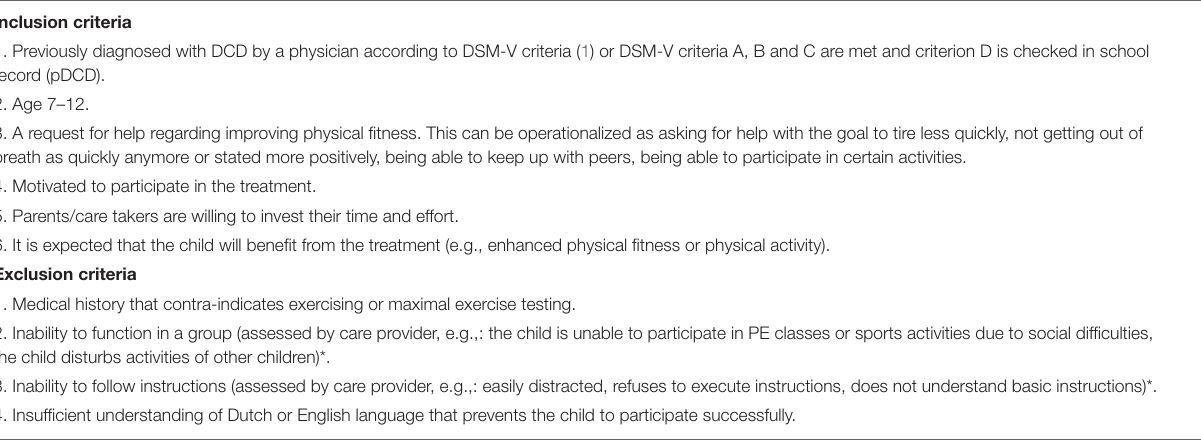
TABLE 2 | In- and exclusion criteria for participation of children with DCD in the treatment. Inclusion